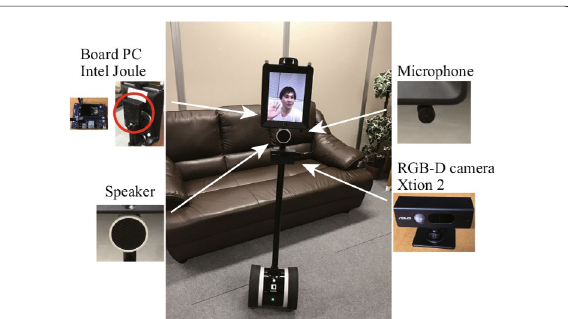
Fig. 16 Communication robot (Double) equipped with a vital sensor